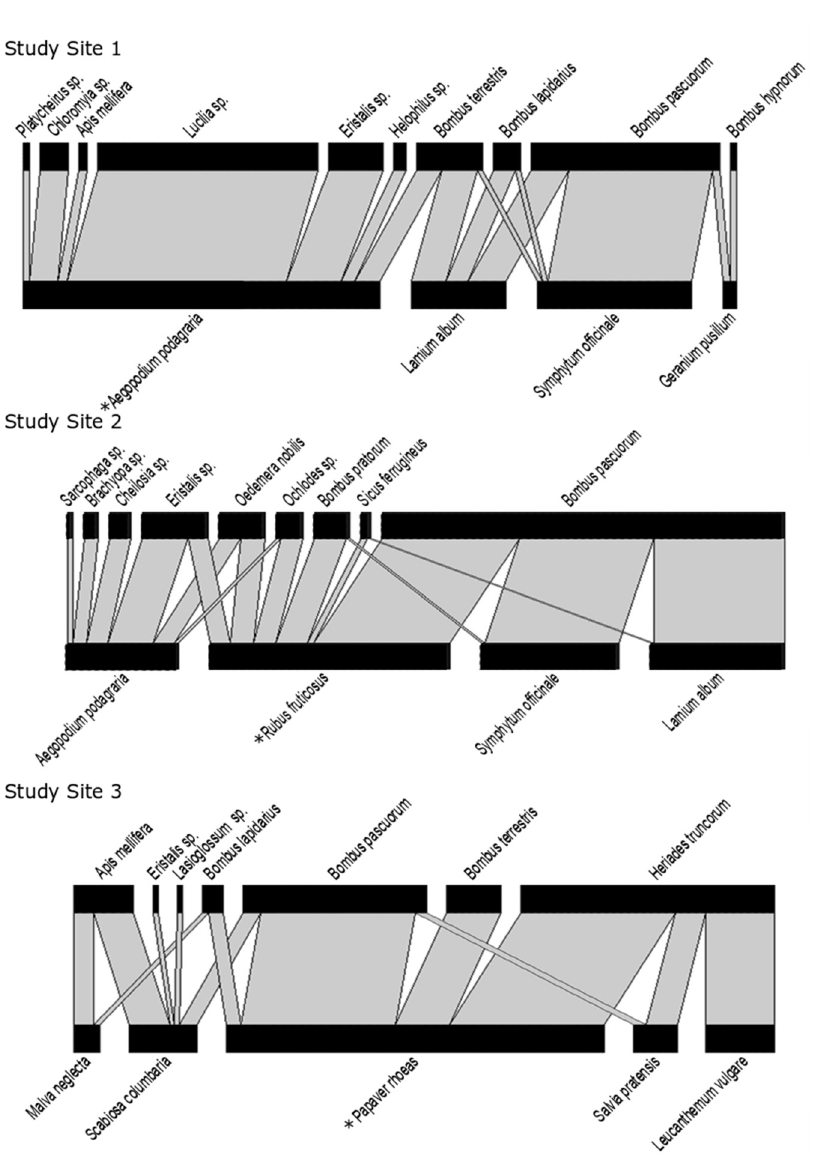
Figure 2. Visualized weighted plant–pollinator networks for each study site; the width of the grey bars corresponds to the average visitation frequency. The most central flower (based on normalized closeness) is indicated with * for each network.